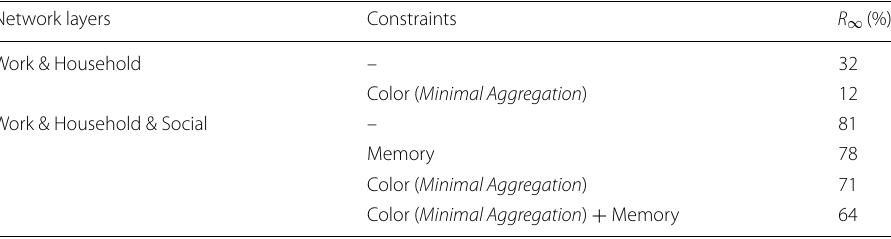
We compare the cases with no restrictions and with different combinations of constraints. We consider here the Minimal Aggregation strategy with ten colors, whose fraction of conflicts is χ =